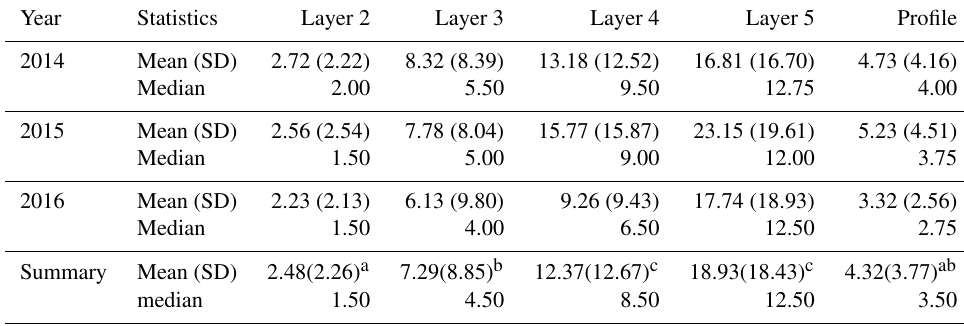
Table 4. The statistics of T opt (day) for each layer and different year for all stations.